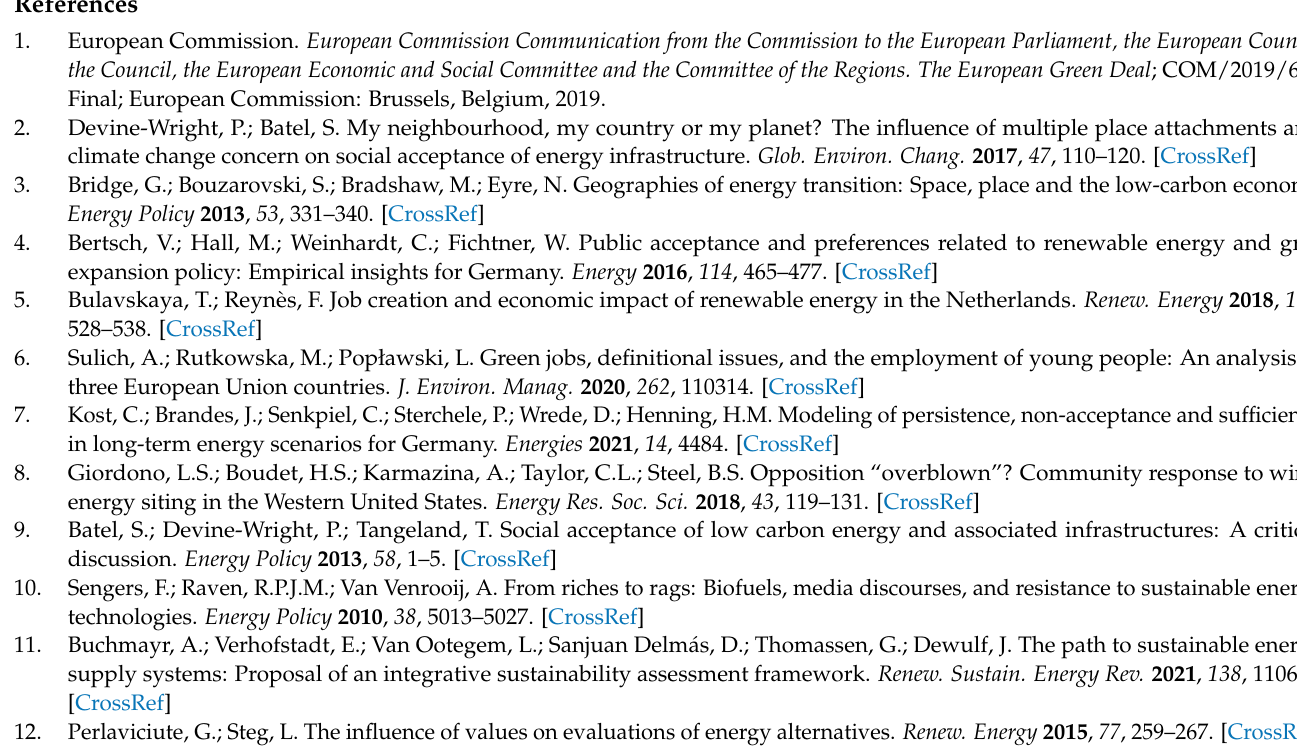
Proportional SD vs. D, N, SD, D vs. N, SD, D, N vs. SD, D, N, A Coef. Sig. Odds Test (Brant) A, SA Coef. A, SA Coef. A, SA Coef. vs. SA